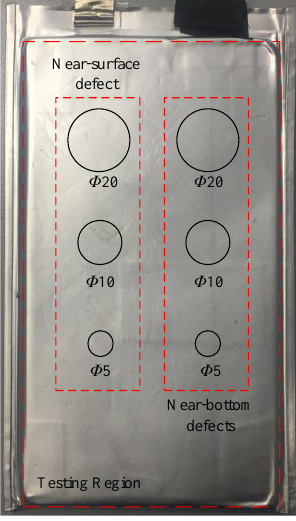
Figure 8. Honeycomb sandwich composite sample and defects layout.